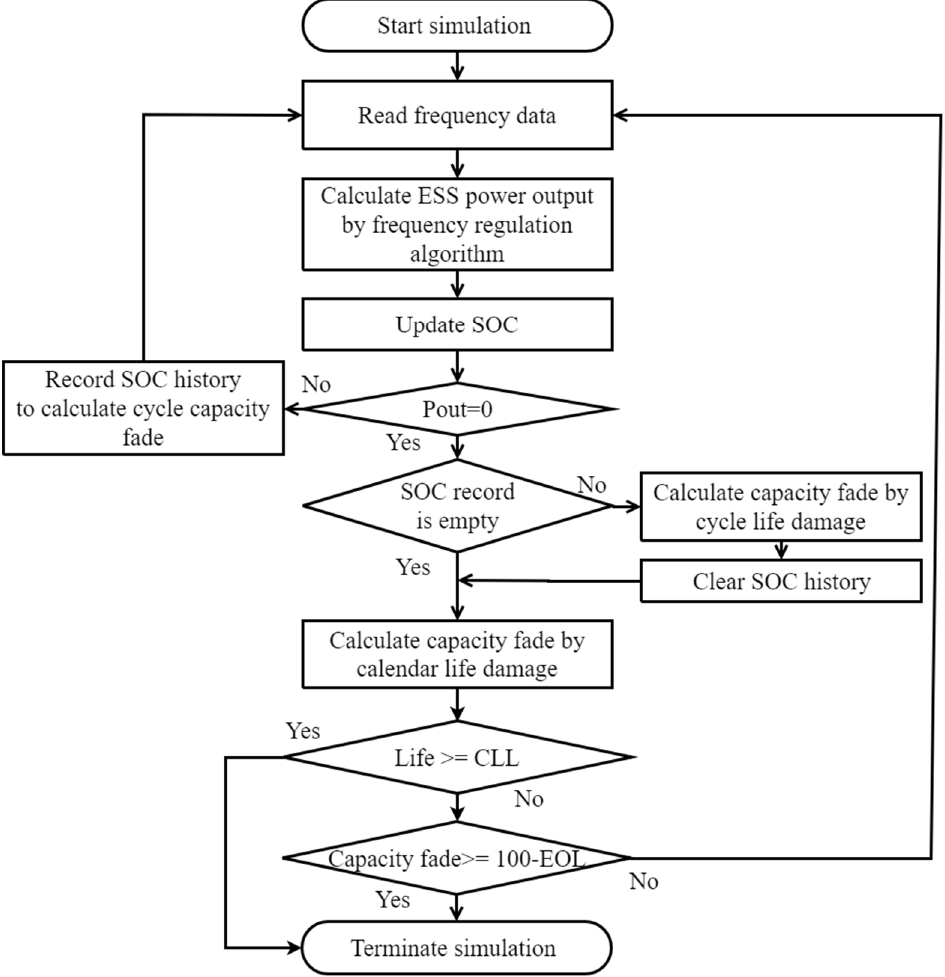
Figure 9. Objective function calculation flow chart.